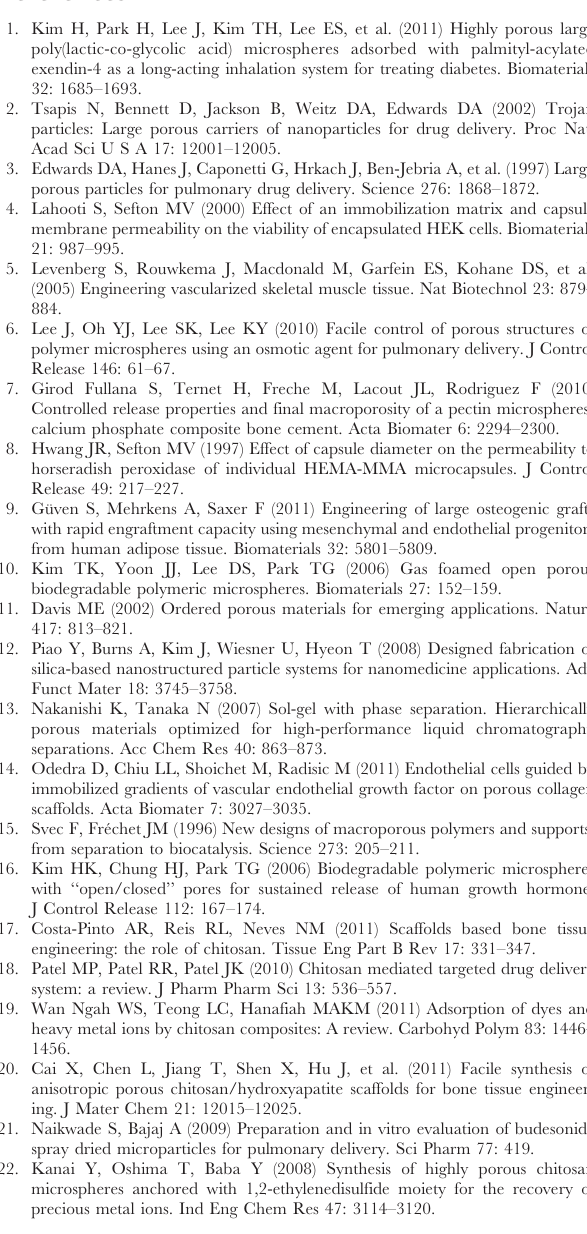
Figure S6 Spheres placed in 1% acetic acid for (a) 20 minutes;